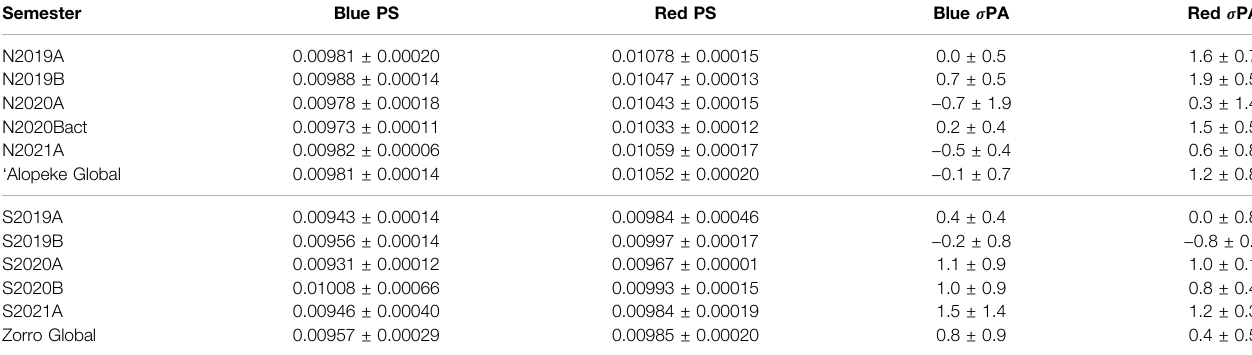
TABLE 4 | Speckle mode average Pixel Scale and Position Angle difference from orbit empherides prediction for each observing semester. Semester